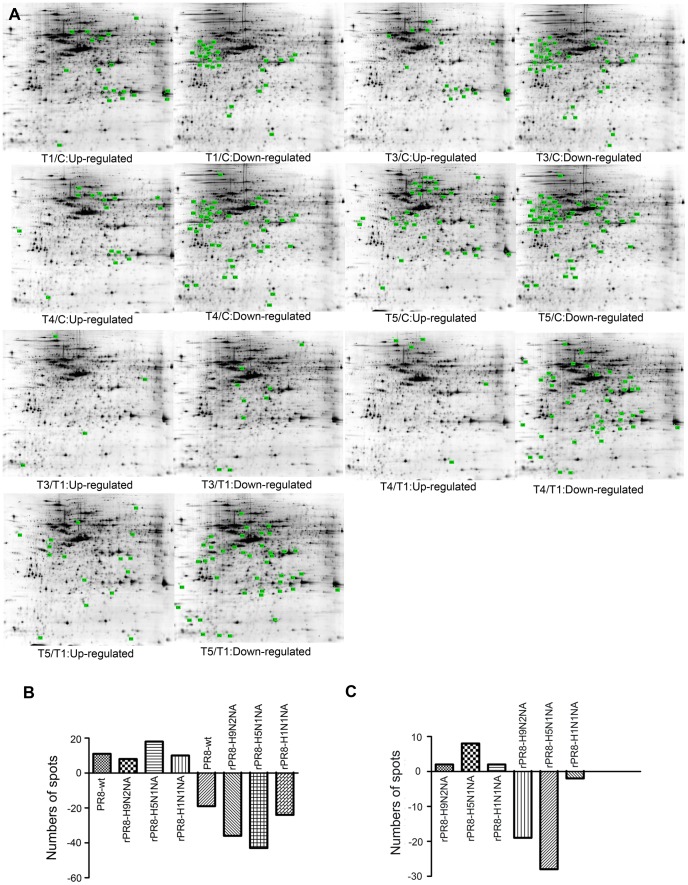
Protein expression profiles of the influenza- and mock-infected MDCK cells.Cell lysates (120 µg) were separated on 13-cm (isoelectric point [pI] 4–7) linear gradient IPG strips using 12.5% SDS-PAGE. Differentially expressed protein spots are indicated with green squares. (A) Representative 2-DE gels of influenza- and mock-infected MDCK cells. T1/C: PR8-wt infected/mock infected, T3/C: rH1N1NA infected/mock infected, T4/C: rH9N2NA infected/Mock infected, T5/C: rH5N1NA infected/mock infected, T3/T1: rH1N1NA infected/PR8-wt infected, T4/T1: rH9N2NA infected/PR8-wt infected, T5/T1: rH5N1NA infected/PR8-wt infected. (B) Numbers of differentially expressed protein spots detected by 2-DE in virus-infected MDCK cells compared with mock-infected MDCK cells. The number of spots ≥0 indicated the proteins were upregulated, and the number <0 indicated the proteins were downregulated. (C) Numbers of differentially expressed protein spots detected by 2-DE in recombinant viruses compared with wild-type virus (wt-PR8)-infected MDCK cells.